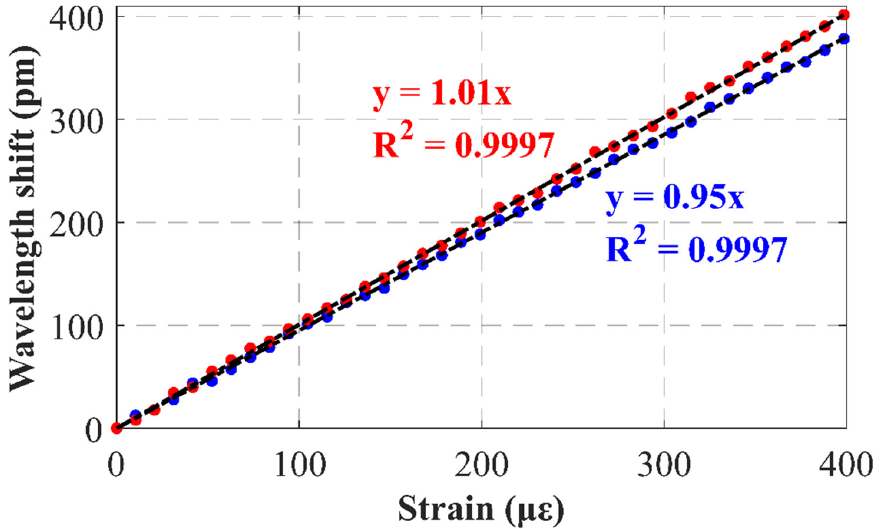
Figure 10. Wavelength shift as function of strain when using the SMF − RR for the 1527.7 nm (blue) and 1530.81 nm (red) emission lines.